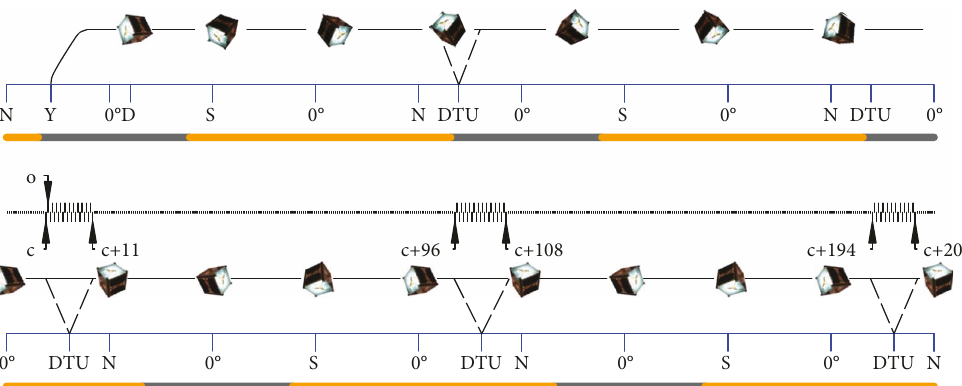
Figure 1: Two segments of the mission timeline for DTUsat-2. The top part shows the launch sequence from Yasny launch complex in Russia (Y), the satellite deployment (D) and satellite contact during fi rst orbit, which passed over DTUsat ground station (indicated with dashed lines). The lower part shows the expected behaviour of the satellite after the attitude control system has locked it to the Earth magnetic fi eld. The letter “ c ” indicates an arbitrary beacon count number between 0 and 32767 in the communication system beacon. During the three consecutive passes, nominal behaviour dictates that the number should steadily increase until it rolls over to zero at 32767. The letter “ o ” indicates the expected on-board computer beacons, which should occur in between the communication system beacons. N, S, and 0 ° indicates North, South, and equator, respectively. The yellow and grey bar indicates daylight and eclipse, respectively.